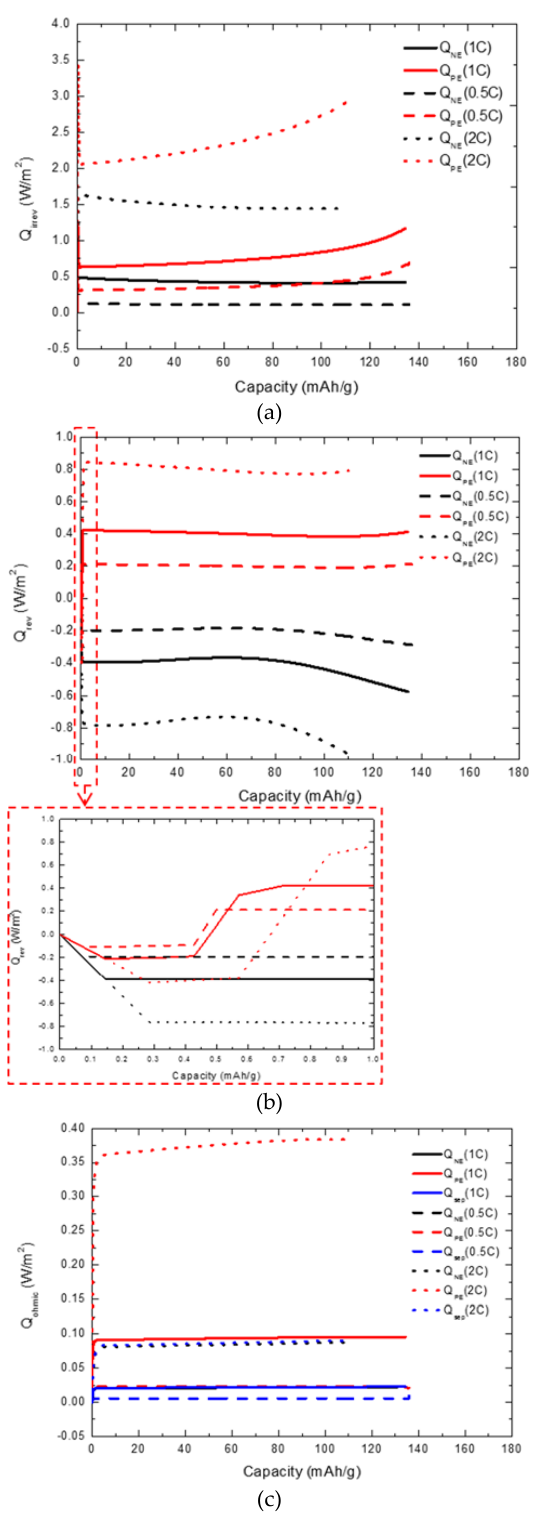
Figure 8. Individual heat generation terms as a function of the cell capacity during discharging: ( a ) irreversible reaction heat, ( b ) entropic heat, and ( c ) ohmic joule heating.